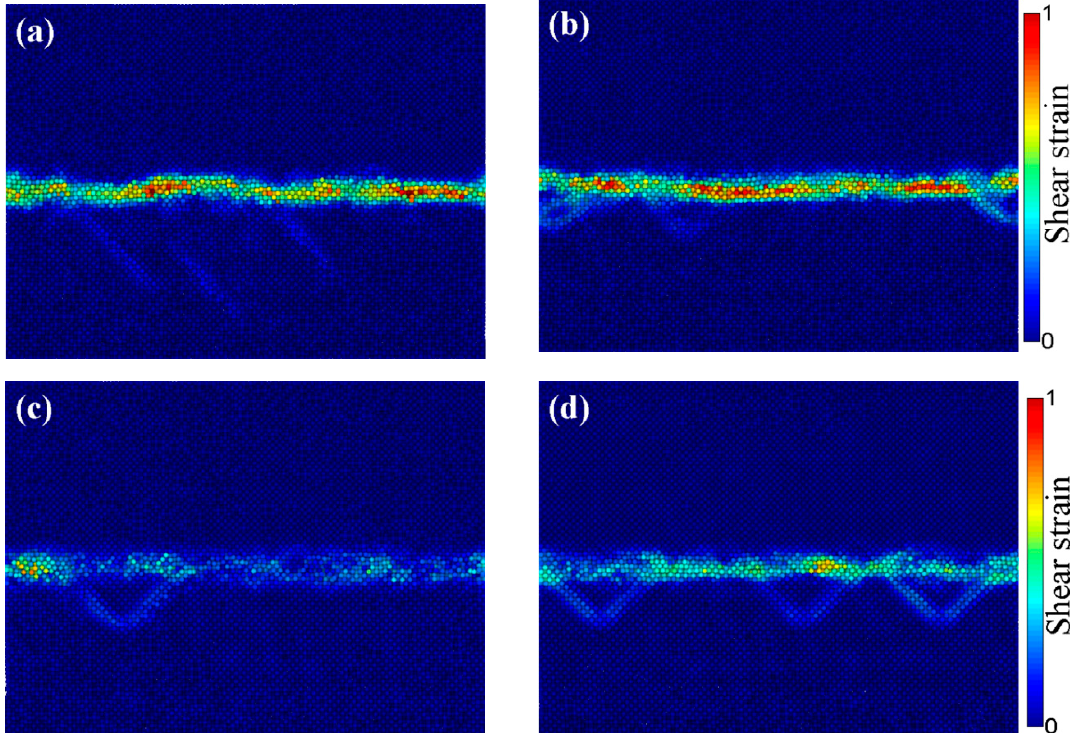
Figure 10. Shear strain distribution at di ff erent welding times: ( a ) 0.5 ns, ( b ) 1 ns, ( c ) 3 ns, and ( d )